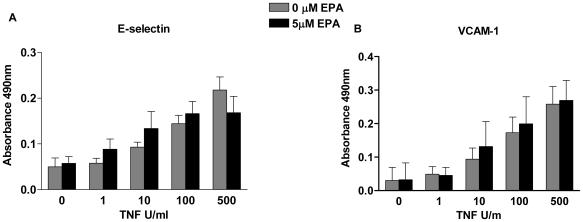
The effect of EPA on TNF-induced surface adhesion molecule expression.The expression of (A) E-selectin and (B) VCAM-1 was measured by ELISA in TNF-stimulated endothelial cells that were either unsupplemented or supplemented with EPA. Data are mean±SEM of seven experiments. ANOVA showed that there was a significant effect of the dose of TNF (p<0.01), but not of EPA, on the expression of both receptors.